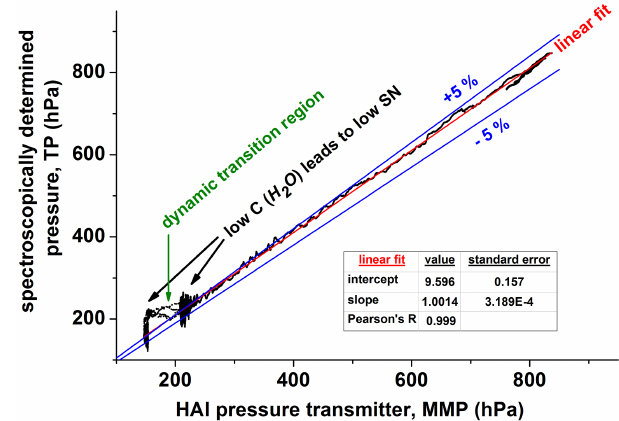
Figure 9. Intercomparison of static ambient avionic pressure (SAP, red), micro-mechanical HAI pressure (MMP, black) and spectro- scopic TDLAS pressure (TP, blue) during certain HALO high- altitude flight manoeuvres and a subsequent descent. A clear in- cidence of HALO’s aerodynamic influence of the effective pressure within the open-path volume of HAI, leading to a strong deviation between the SAP and the HAI pressures (MMP/TP), can be seen on the left between 10:30 and 11:00. The block-shaped pressure devi- ations of 70hPa (i.e. 30% relative 1p ) are caused by self-shading of HAI during a HALO manoeuvre caused by a change in the angle of attack (green line, right scale in green) and velocity (orange line and scale on right) of the aircraft. (The resulting constraints in using HALO’s avionic pressure measurement are discussed in the text.) At lower flight heights and less critical manoeuvres ( t = 11:20), all three pressure signals agree within 1% (9hPa at about 830hPa) (see inset on the right).